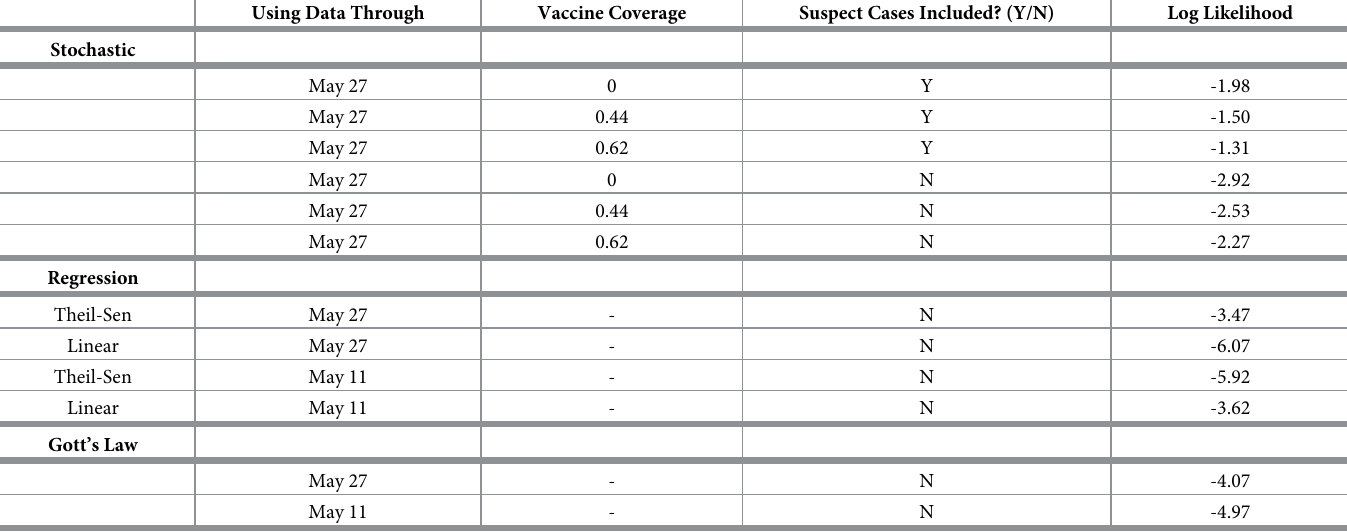
Table 4. Probabilistic scoring for stochastic branching process model, regression models and Gott’s Law. Date of prediction, vaccine coverage, inclusion of suspected cases and log-likelihood. For the regression model: Method 1—Theil Sen regression with a pseudo-log transformation. Method 2—OLS Linear Regression without trans- formation. Our mathematical models were scored against the actual outbreak size of 54 EVD cases. Note: “-”indicates that the model did not include vaccine